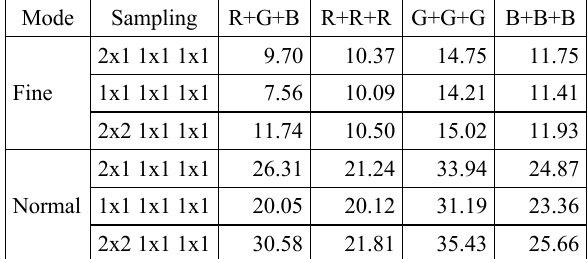
caused by lossy JPEG compression against radial distances . The signed displacements caused by lossy JPEG compression were calculated by using Equation (4) and Equation (5) in the same way as the signed displacements caused by chromatic aberration were calculated. Solid lines in Figure 7 show approximate cubic functions as